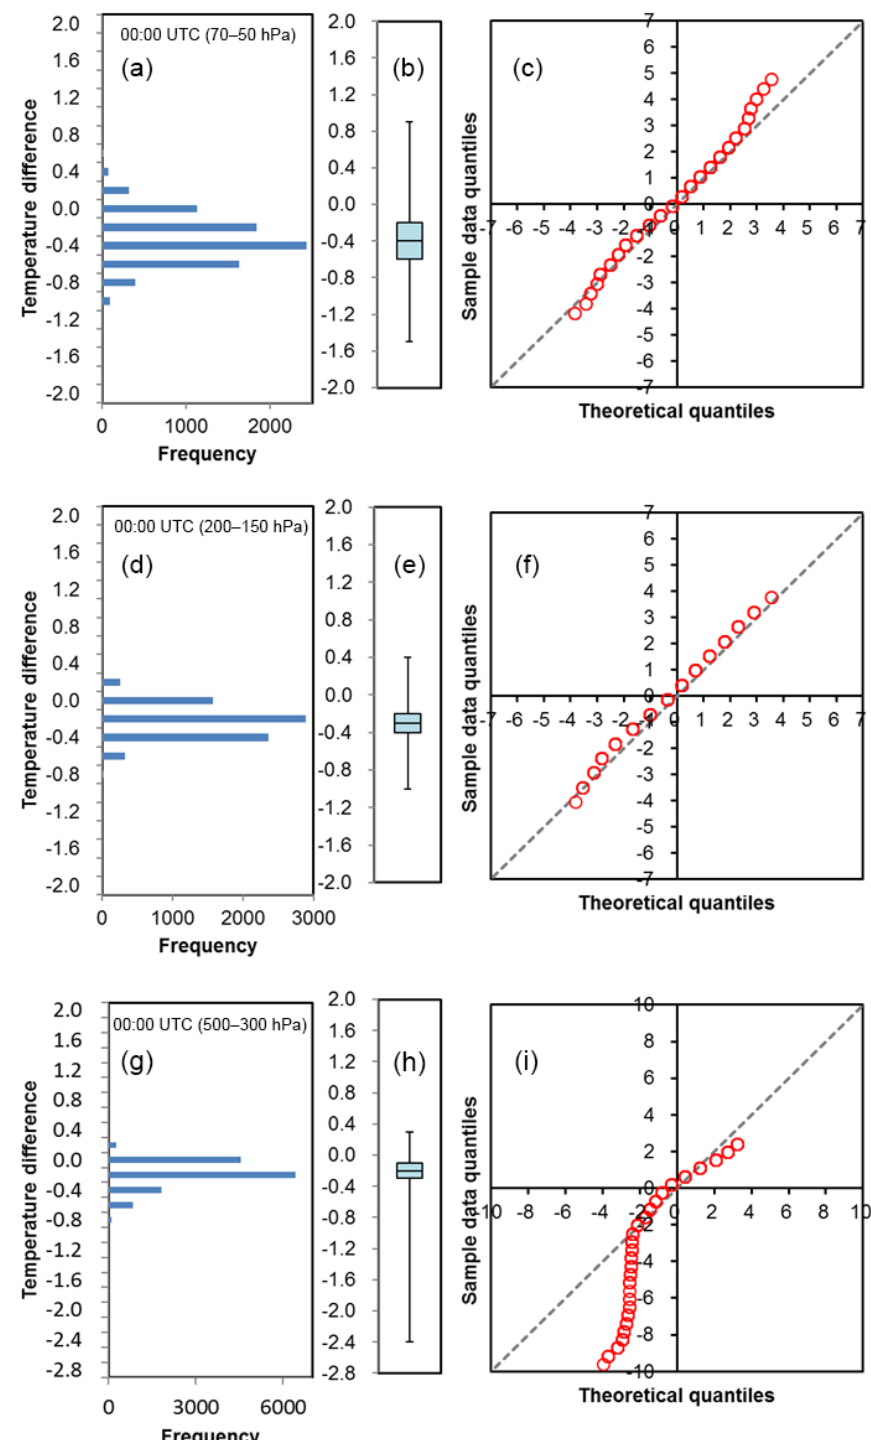
Figure 25. Distribution of the temperature differences between RS-11G GDP and RS92 GDP for daytime observations (histogram in a, d, g , box plot in b, e, h , and quantile–quantile plot in c, f, i ). Shown are the results for the pressure layers between 70 and 50hPa (a–c) , between 200 and 150hPa (d–f) , and between 500 and 300hPa (g–i)